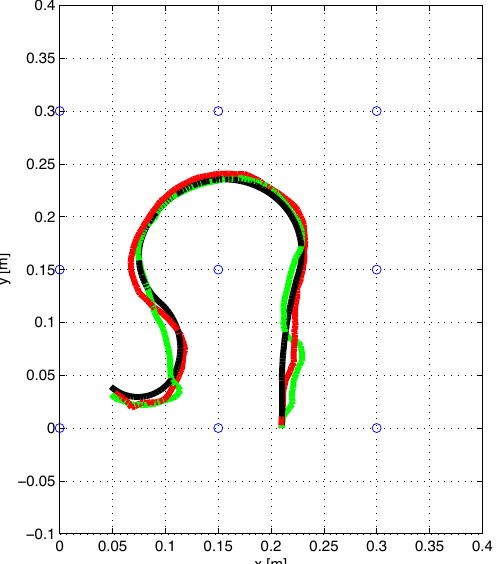
Figure 10. Experimental results: position estimation under two orientation configurations. The black line is the true trajectory, the green line is the estimated trajectory with the first configuration, i.e., initial coil orientation a = 0, b = 0 and c = 1, the red line is the estimated trajectory with the second configuration, i.e., coil orientation a = 0.72361, b = − 0.52573 and c = 0.44721.